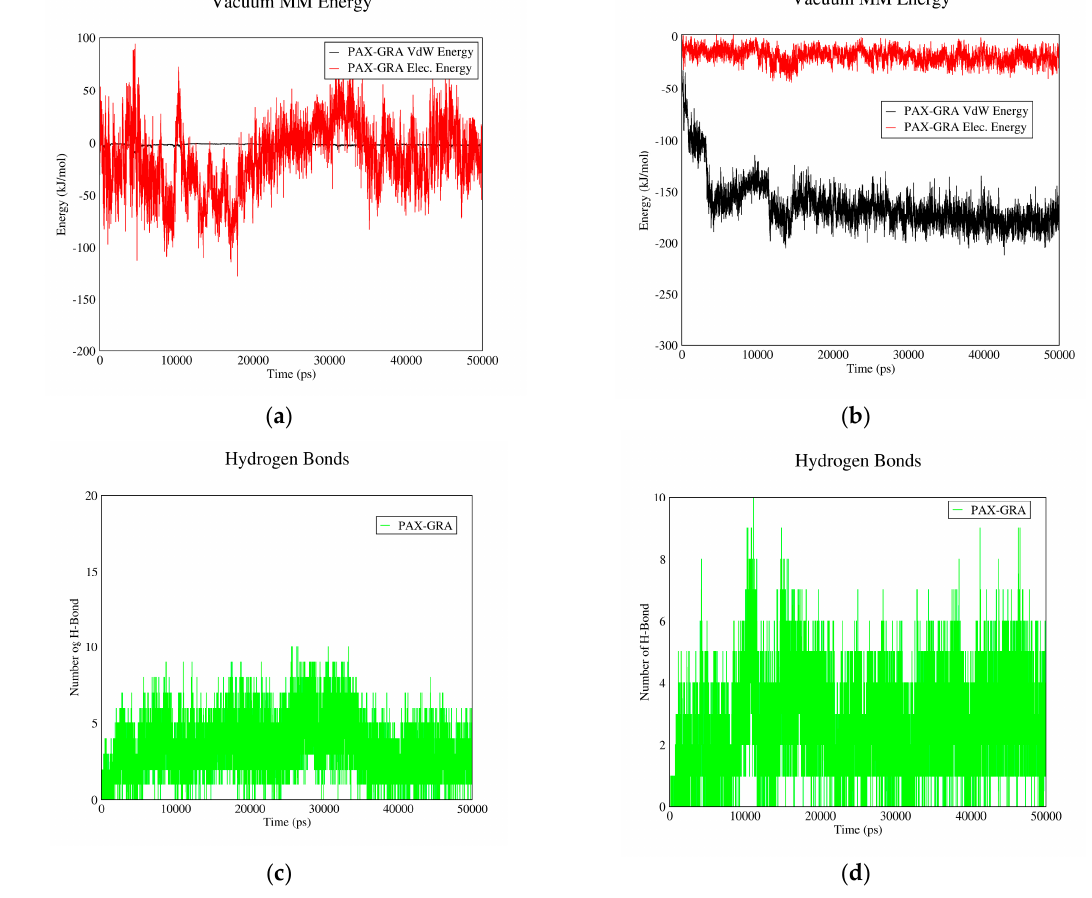
Figure 6. PAX–GO interaction energies and hydrogen bonds: ( a ) electrostatic and Van der Waals energies of PAX–GO interaction versus time in neutral pH; ( b ) electrostatic and Van der Waals energies of PAX–GO interaction versus time in acidic pH; ( c ) the number of hydrogen bonds between PAX and GO versus time in neutral pH; ( d ) the number of hydrogen bonds between PAX and GO versus time in acidic pH.